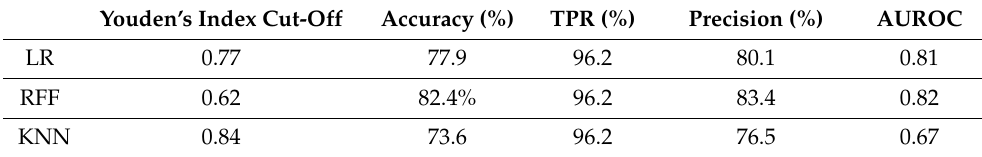
Table 2. Algorithms Performance. In bold the algorithm with the best performance on 10-fold cross validation. Accuracy, Recall, Precision and AUROC for RFF, were significantly better than other algorithms’